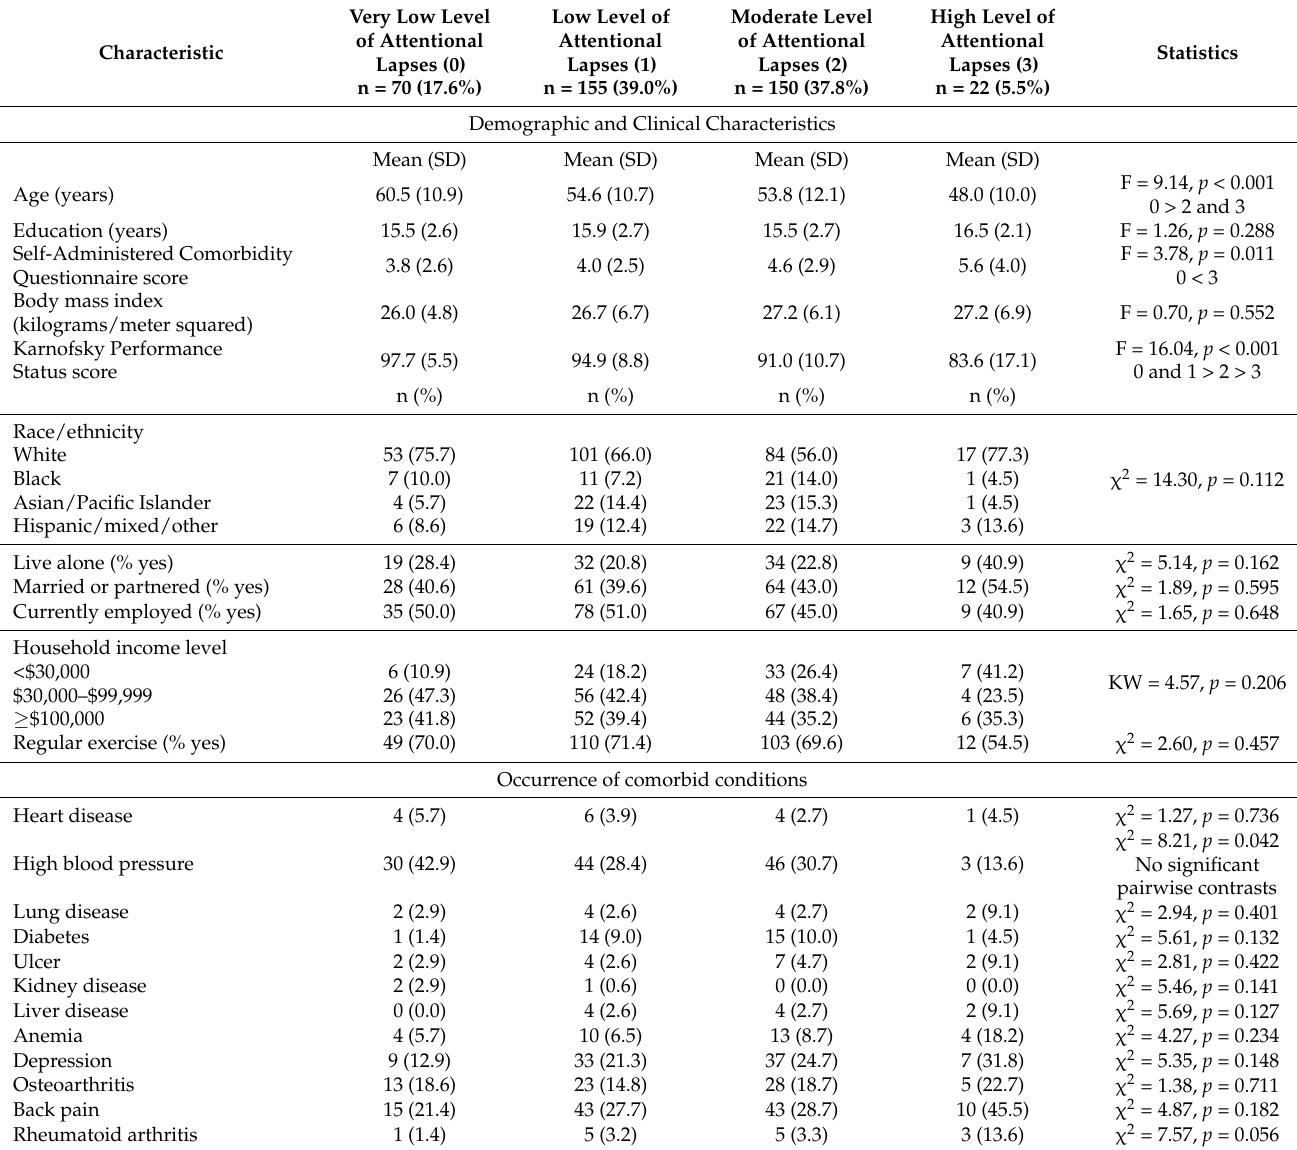
Table 5. Differences in Demographic, Clinical, and Symptom Characteristics Among the Attentional Lapses